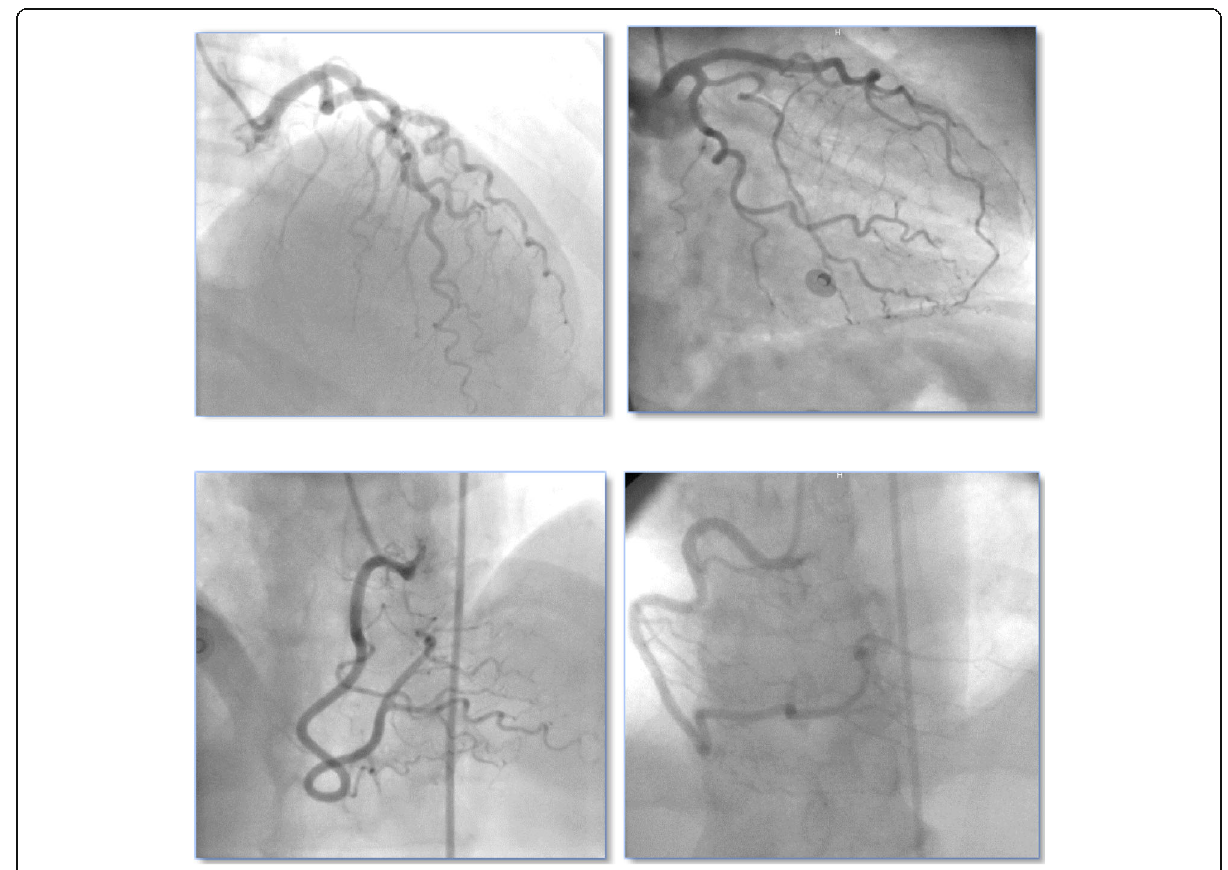
Fig. 1 Coronary angiograms for different patients showing tortuosity in anteroposterior view with cranial angulation